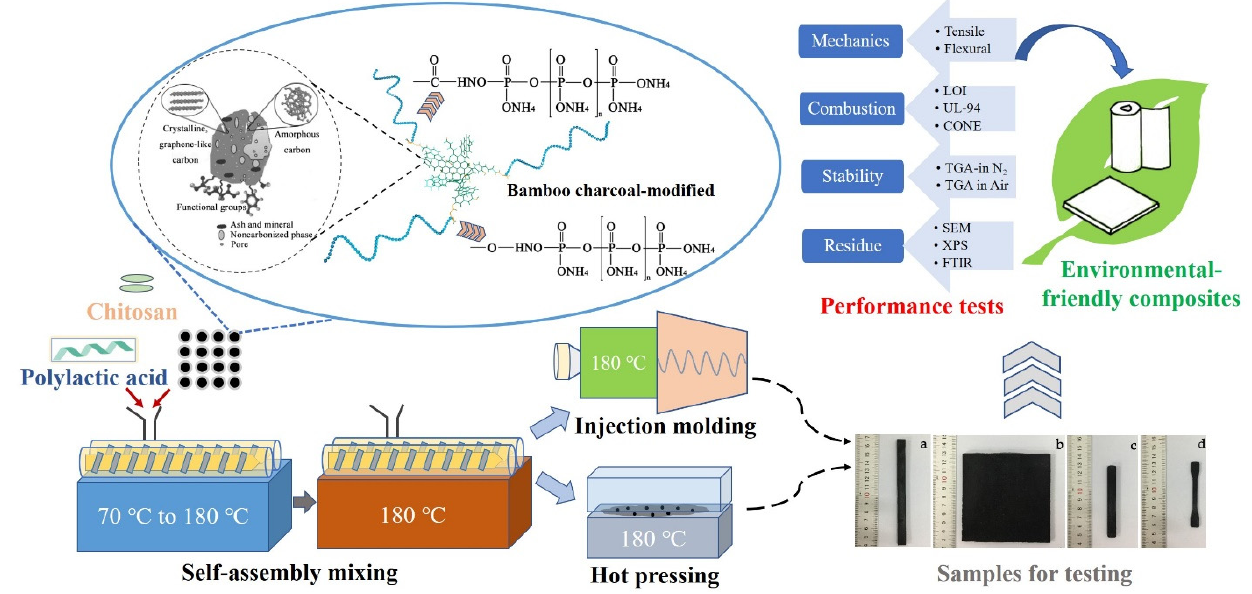
Figure 1. Schematic diagram of composite preparation and testing.